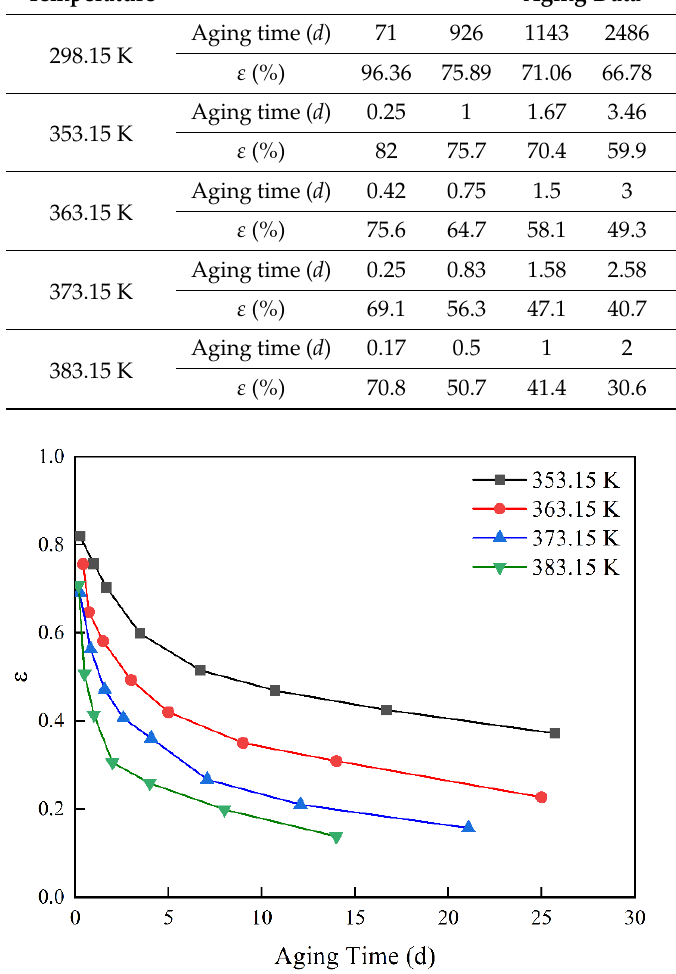
Figure 1. Changes in compression set retention with time. Table 1. Compression set retention ( ) at different aging temperatures [23].